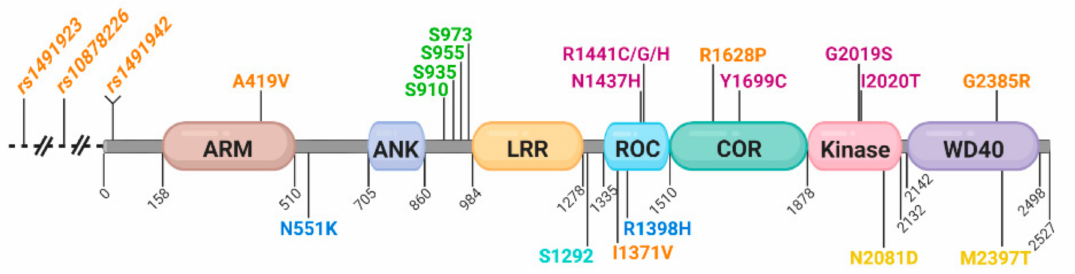
Figure 1. Domain architecture, genetic risk variants, and regulatory phosphorylation sites of LRRK2 (leucine-rich repeat kinase 2). LRRK2 is a large kinase of 2527 amino acids with multiple identifiable functional domains. Variants classified as pathogenic according to MDSGene are in magenta, while risk factor variants pending conclusive classification are in orange; putative protective mutations are in blue; variants associated with inflammatory bowel disease (IBD) are in yellow. Regulatory phosphorylation sites are in green, and LRRK2 autophosphorylation site Ser1292 is in teal. ARM—armadillo domain; ANK—ankyrin domain; LRR—leucine-rich repeat domain; Roc—GTPase domain; COR—carboxy terminal of Roc